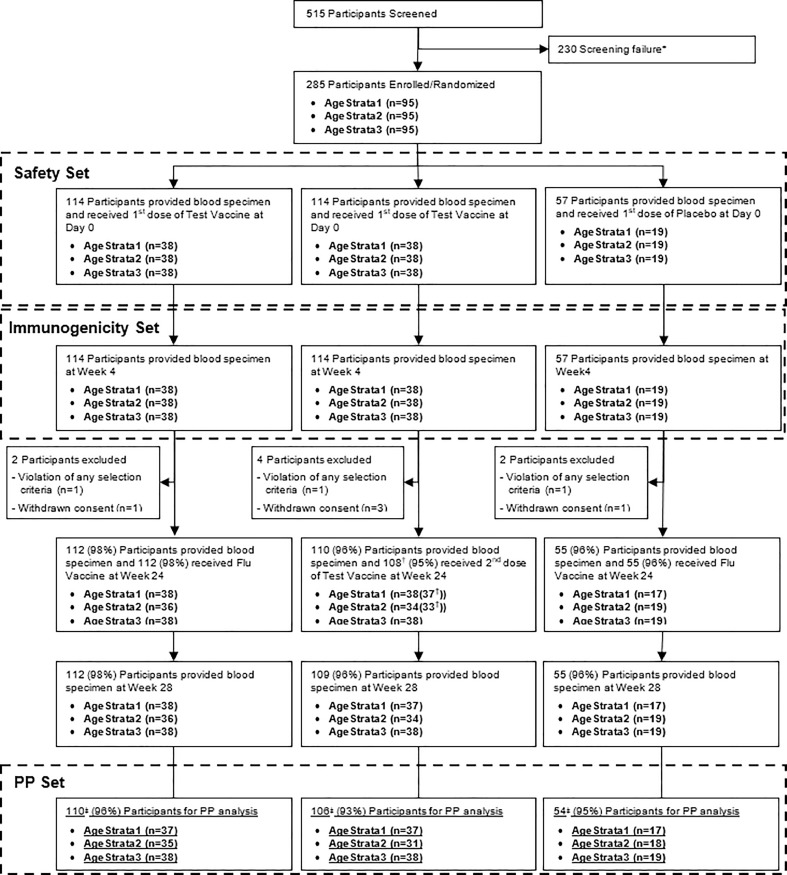
Flow diagram of participant disposition (CONSORT flow diagram). * Screen failure – included participants that had abnormal laboratory values on screening, which included abnormal hematological profile, liver enzymes, renal function test and others; † One participant in each age strata 1 and 2 did not receive the 2nd dose of Test Vaccine; ‡ 5 participants (2 in Vi-DT Single dose Group, 2 in Vi-DT Two-dose Group, 1 in Comparator Group) who had delayed the 2nd vaccination. Four participants did not receive the second dose of Vi-DT – once participant due to violation of the selection criteria (i.e., moved out of study area) and three due to withdrawal of consent.